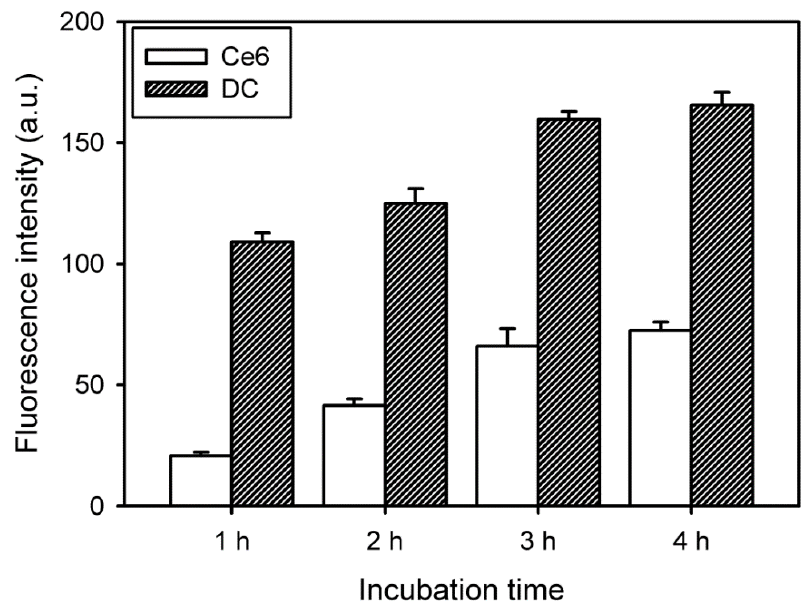
Figure 5. Change in fluorescence intensity due to intracellular uptake of free Ce6 and DC (4 μg/mL Ce6) in HeLa cells as a function of incubation time ( n = 5).